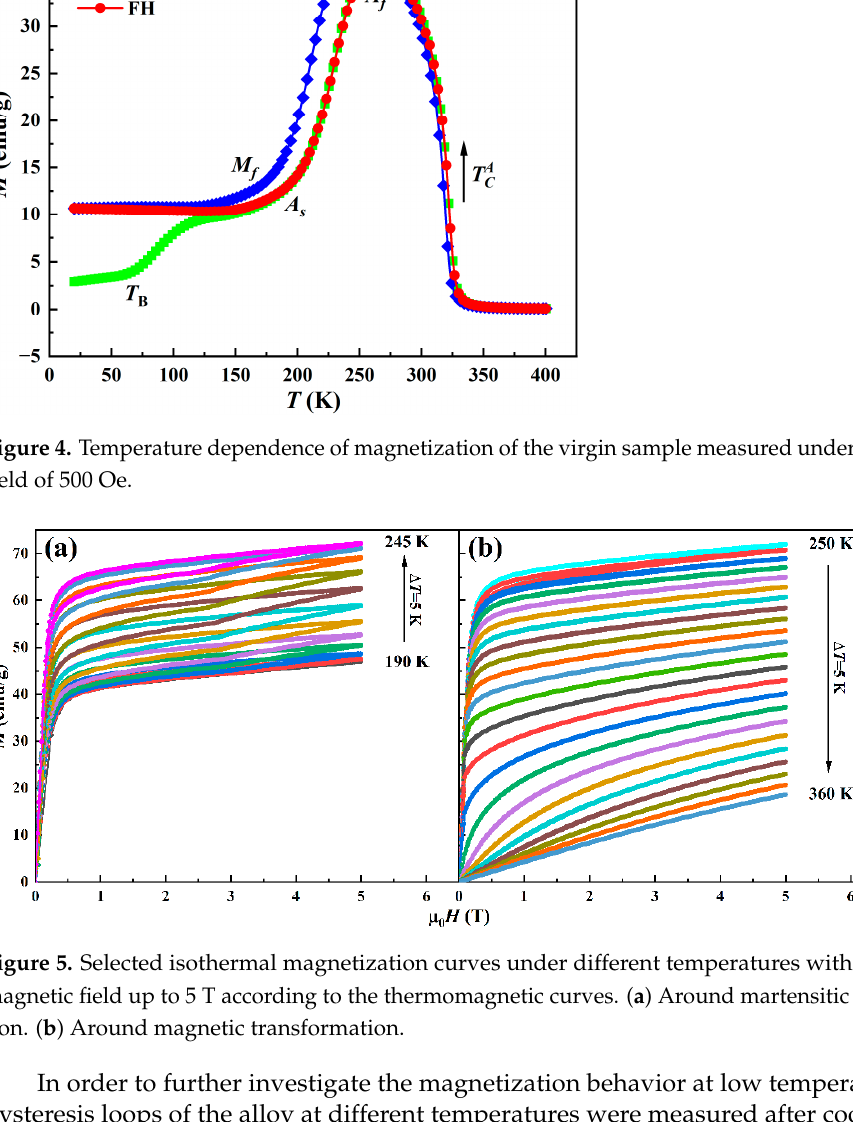
Figure 6. Magnetization hysteresis loops measured at ( a ) T = 2 K, ( b ) T = 20 K, ( c ) T = 65 K, and ( d ) T = 120 K. The magnetocaloric effect was estimated by the values